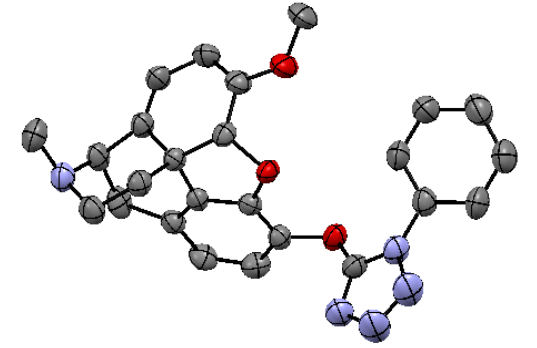
Figure 2. X-ray structure of compound 6, showing 50% probability displacement ellipsoids (H atoms omitted for